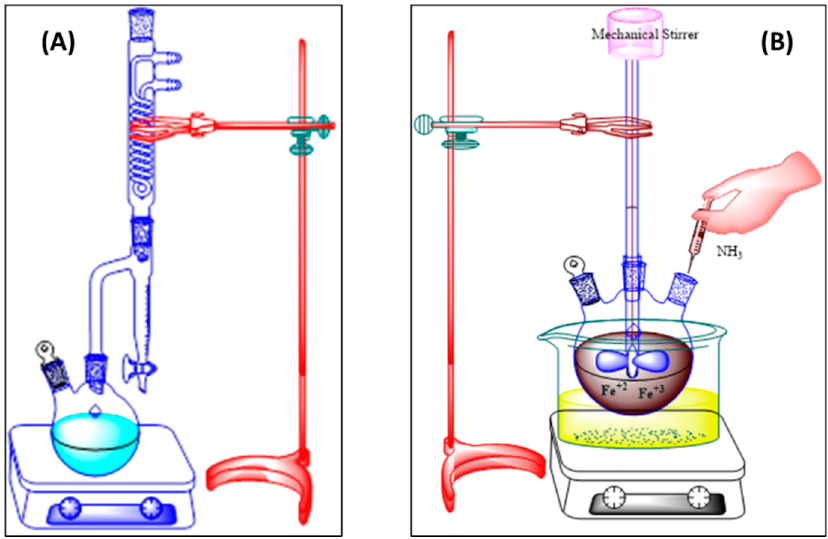
Figure 1. ( A ) Synthesis of multipotent antioxidants; ( B ) synthesis of IONP.